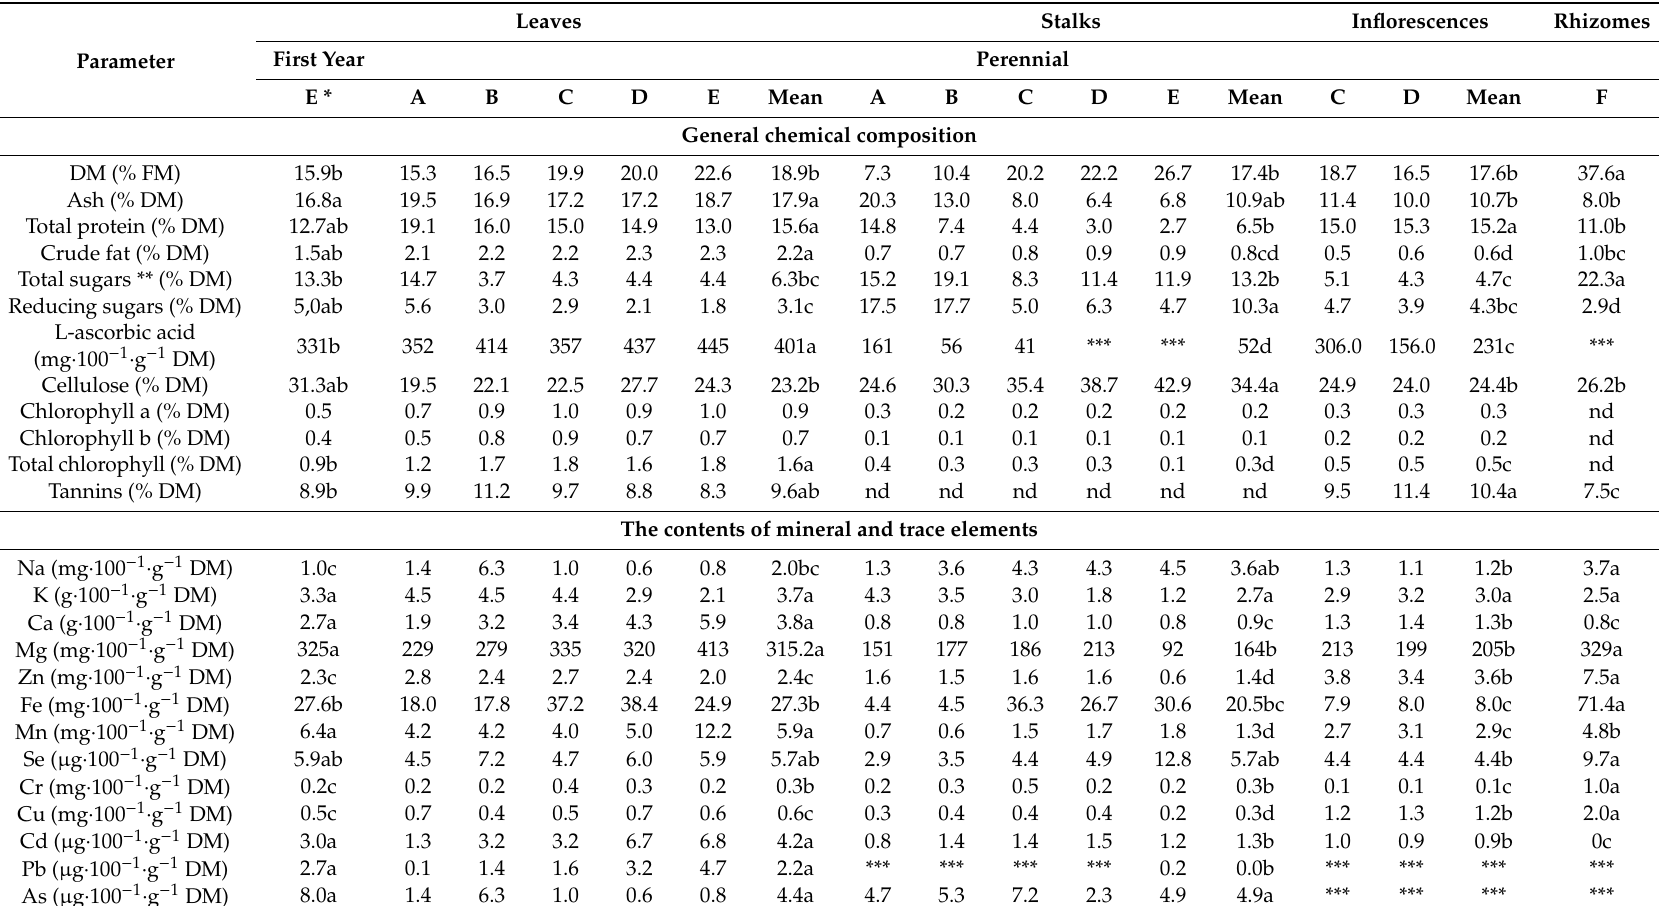
Table 4. Chemical composition of Silphium trifoliatum